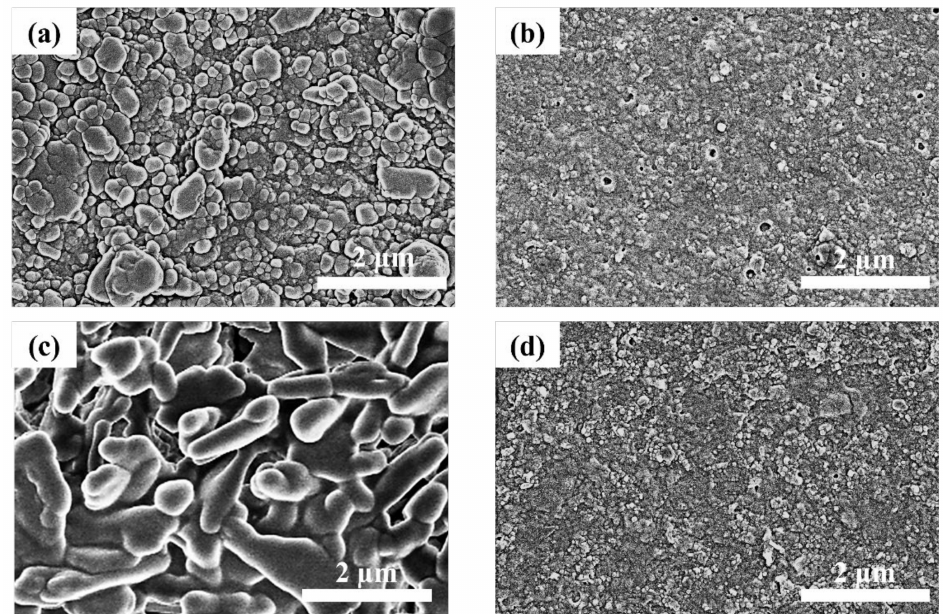
Figure 7. SEM images of the Cs 4 PbBr 6 MC films before ethanol/water treatment ( a ) without PAA and ( b ) with PAA. SEM images of the CsPbBr 3 MC films after ethanol/water treatment ( c ) without PAA and ( d ) with